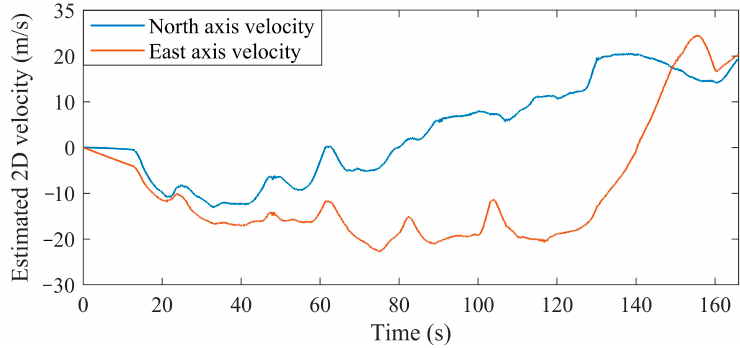
Figure 11. The orientation error for ( a ) roll angle, ( b ) pitch angle, and ( c ) heading.